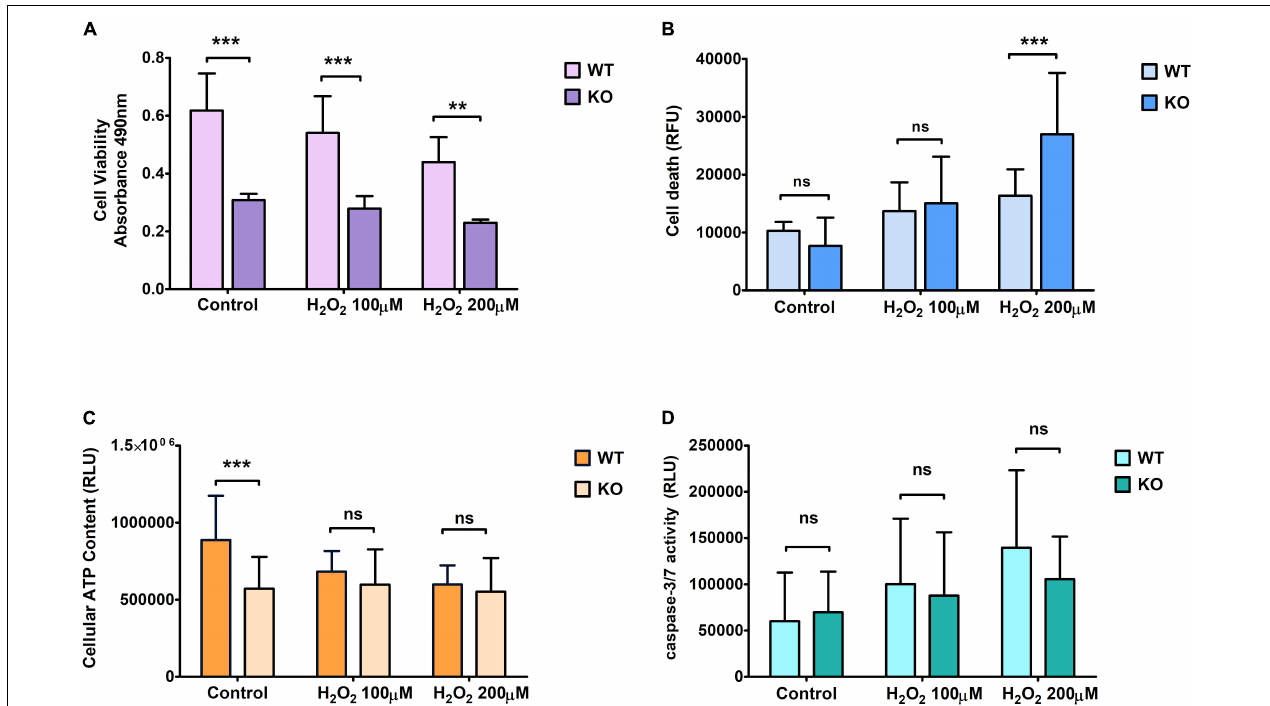
FIGURE 1 | Effect of hydrogen peroxide treatment at different concentrations on primary cortical cells of WT and KO. Cell viability (A) , Cell death (B) , ATP levels (C) , and Caspase 3/7 (D) activity was measured using various cell plate-based assays. Graphs represent mean with SD of 18–25 data points from independent cell culture wells. Two-way ANOVA was performed with the Bonferroni post-hoc test to compare KO and WT for cells exposed to oxidative stress with significance levels (** ≤ 0.01, and *** ≤